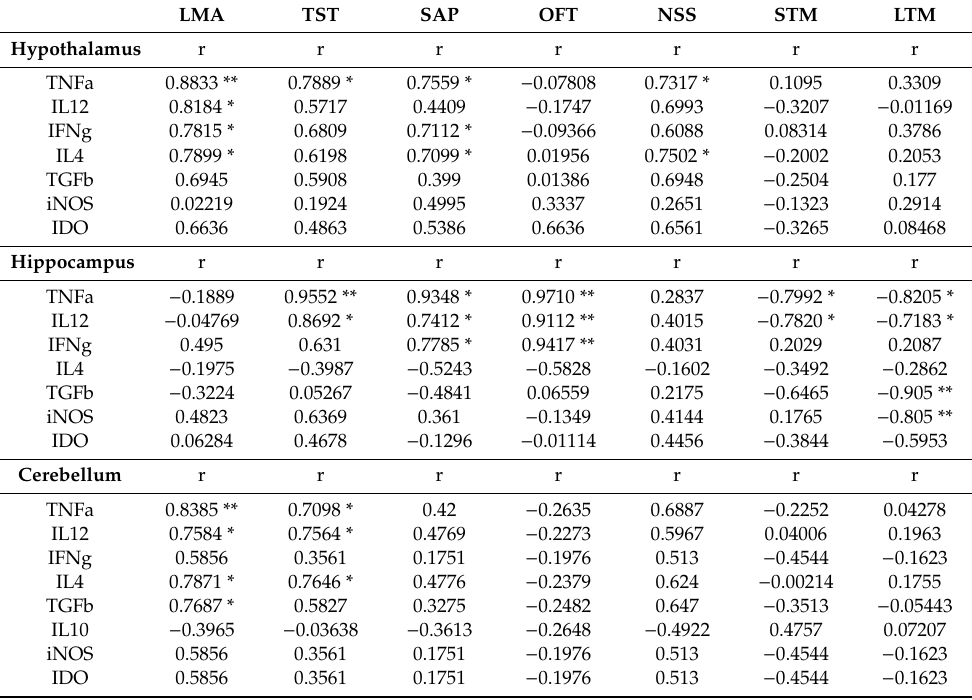
Correlation of behaviour abnormalities with cytokines levels in the hypothalamus, hippocampus and cerebellum showed by TB mice 1 . LMA